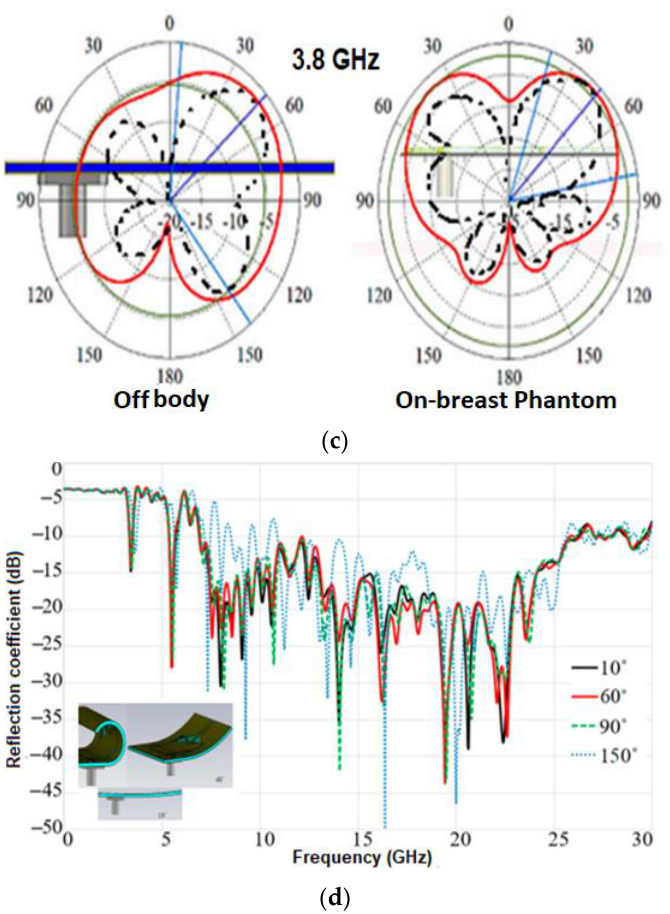
Figure 10. ( a ) Fabricated antenna prototype. ( b ) Radiation patterns. ( c ) S11 of the antenna on-body and off-body. ( d ) S11 results for different bending degrees. Reprinted ( a – d ) from Ref. [6].